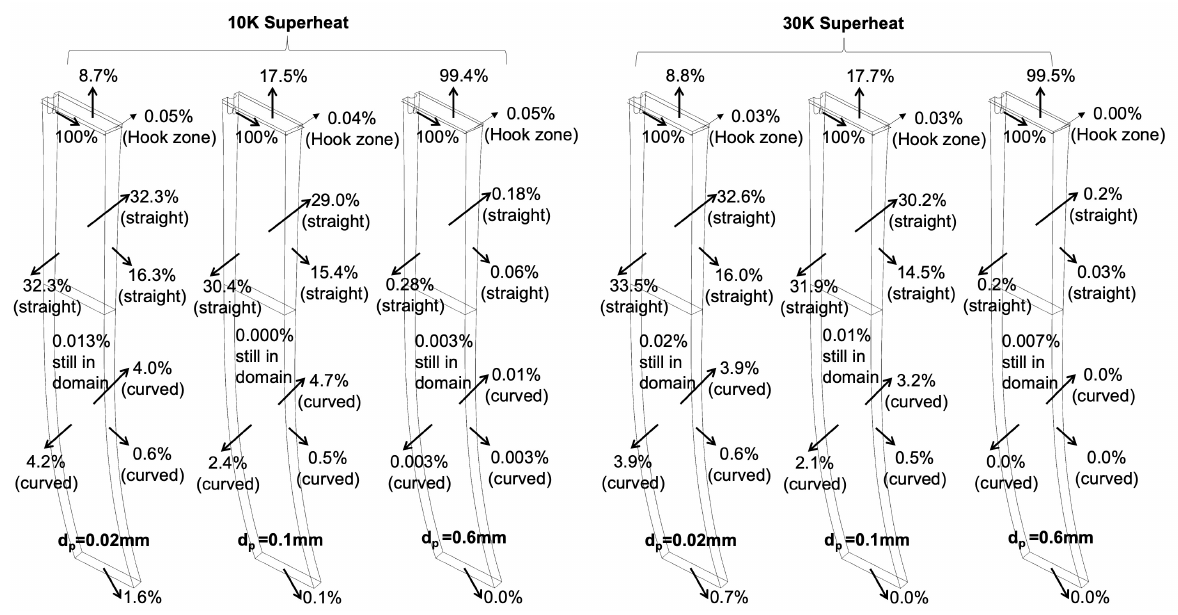
Figure 22. Capture/escape fractions to different strand regions for selected bubble